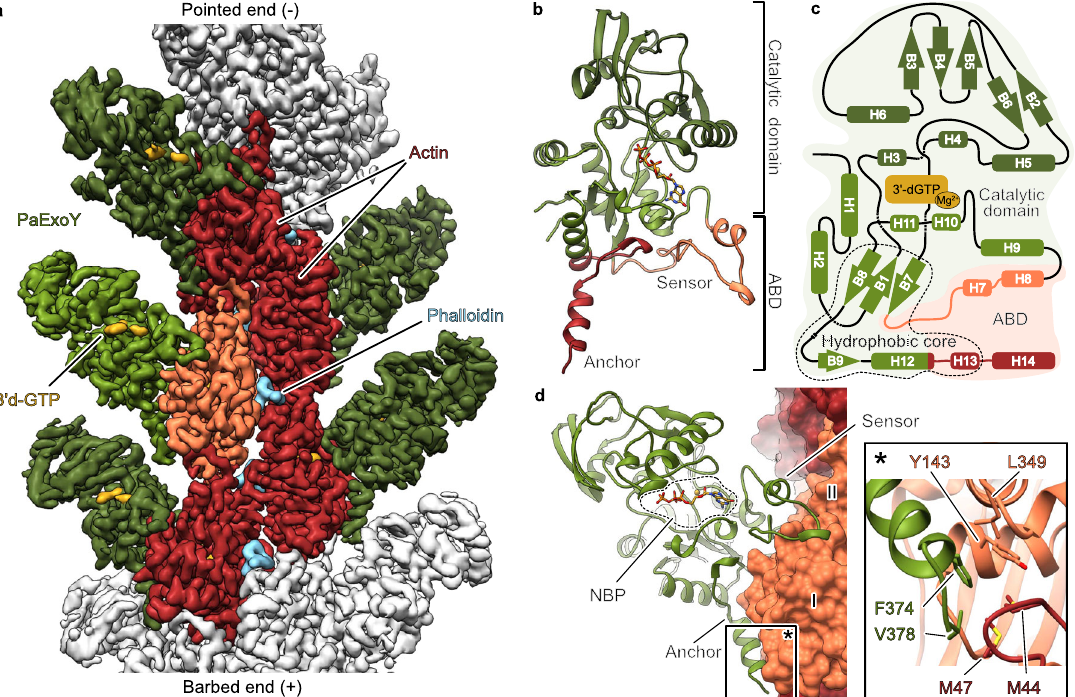
Fig. 1 Cryo-EM structure of PaExoY in complex with F-actin. a The postprocessed map of the PaExoY-F-actin complex. The central actin subunit is colored in orange. Its surrounding 4 neighbors are shown in dark red. PaExoY is in green. b Domain organization of PaExoY. c Schematic representation of the secondary structure elements of PaExoY. d Overview of the PaExoY-F-actin interface. Actin subdomains are shown in surface representation and are marked by roman numerals. ABD actin-binding domain, NBP nucleotide-binding